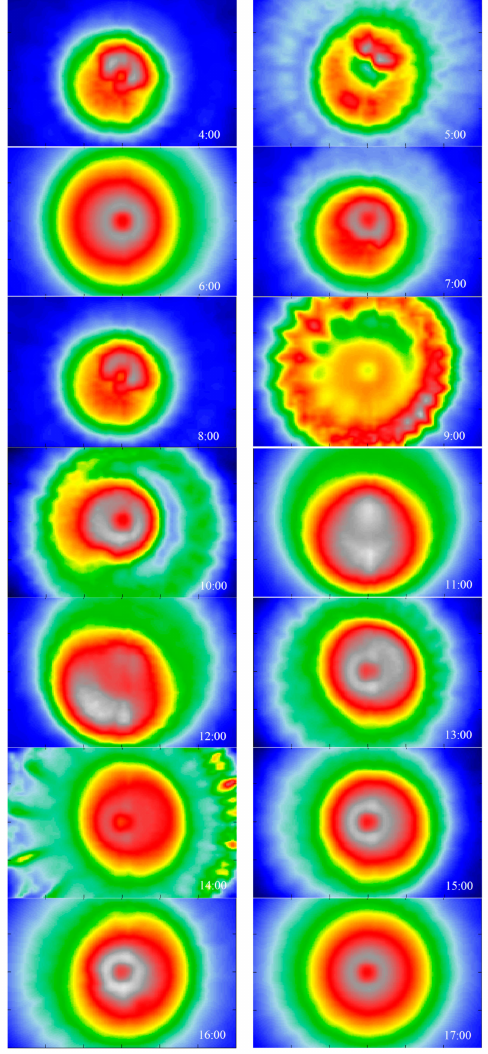
Figure 13. From left to right, from up to down: Work plane illuminance distributions computed from the UMRP model using data taken in Bratislava on 14 June at